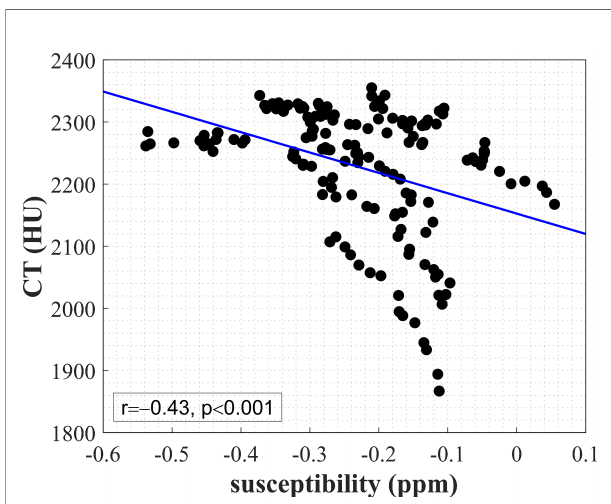
FIGURE 4 | A signi fi cant negative correlation (r= − 0.43, p<0.001) between the mean susceptibility value and mean CT value in 158 ROIs of cortical bone from the bilateral knee joints of 5 subjects. The blue line was obtained from linear